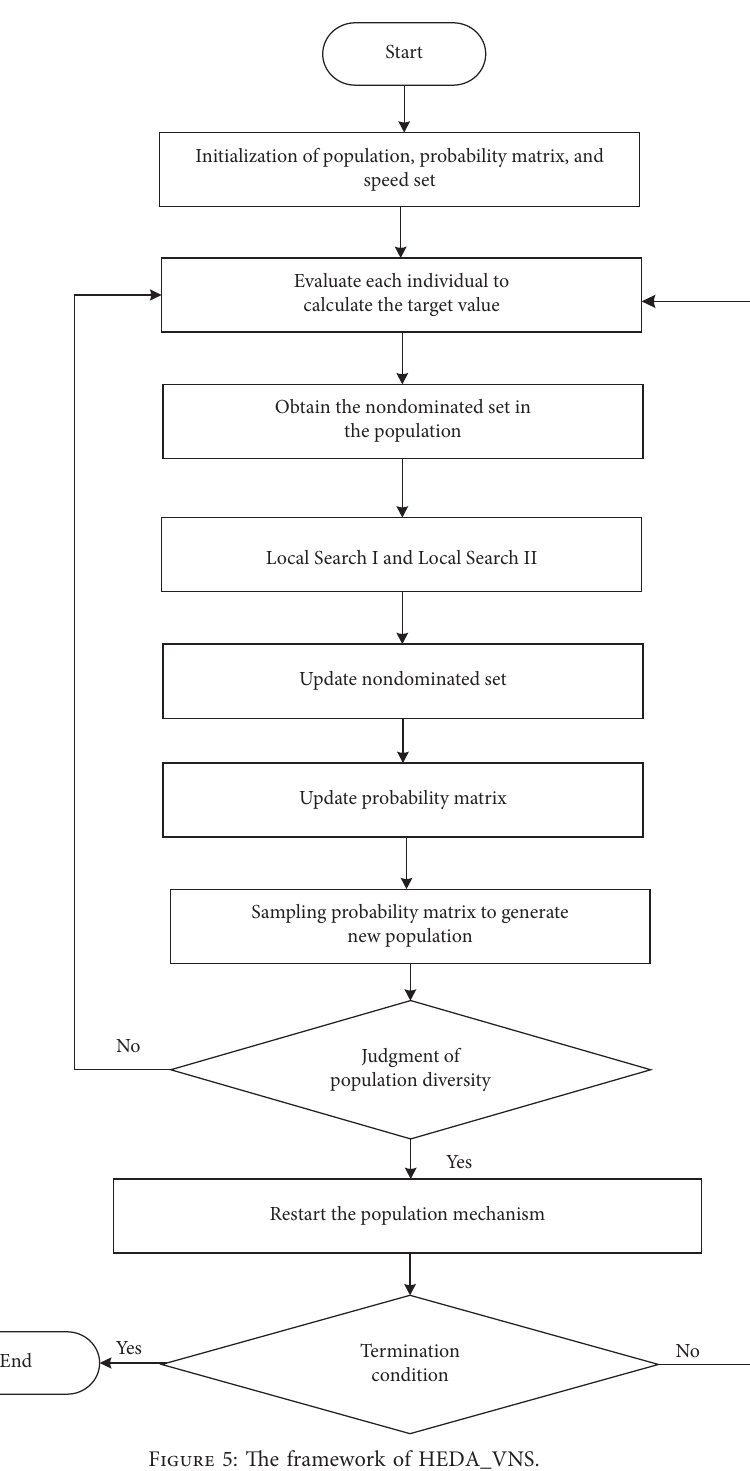
Figure 5: The framework of